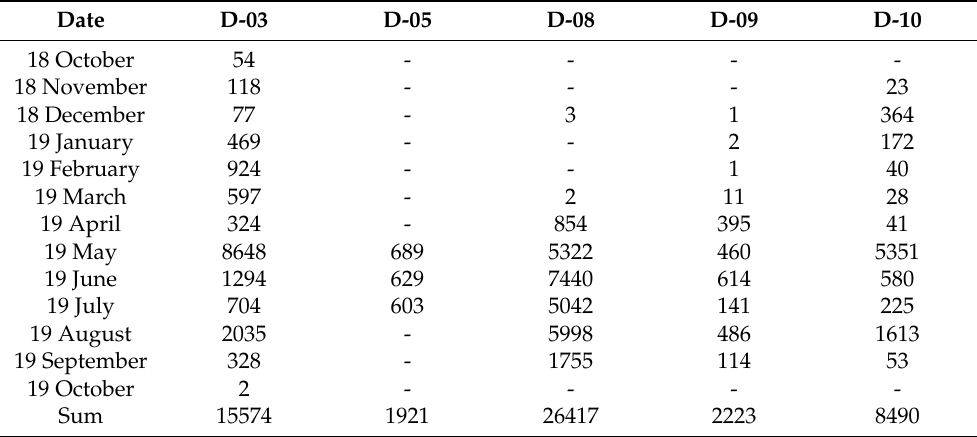
Table 2. Monthly groundwater use of main pumping wells in the study area. (unit: m 3